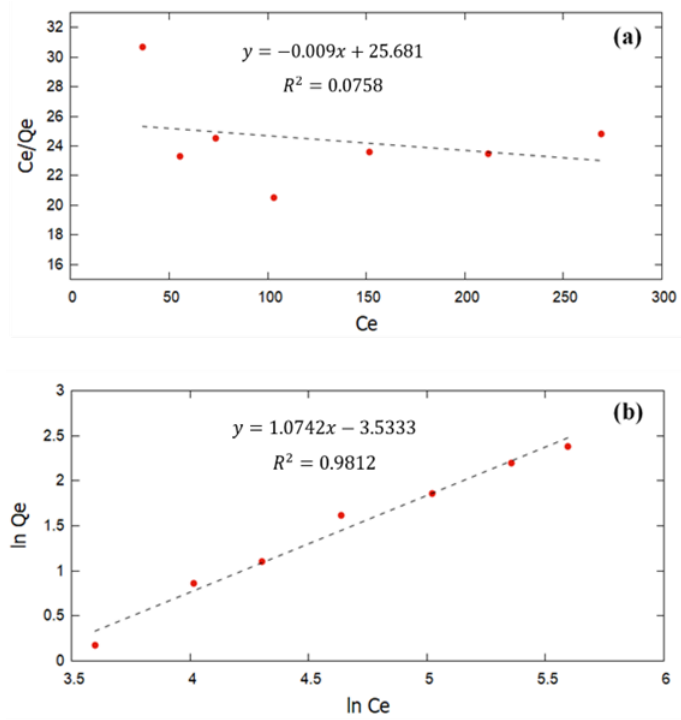
Figure 8. ( a ) Langmuir isotherm and ( b ) Freundlich isotherm plots. Table 4. Equilibrium data and correlation factor of Freundlich isotherm model. Freundlich Isotherm Model